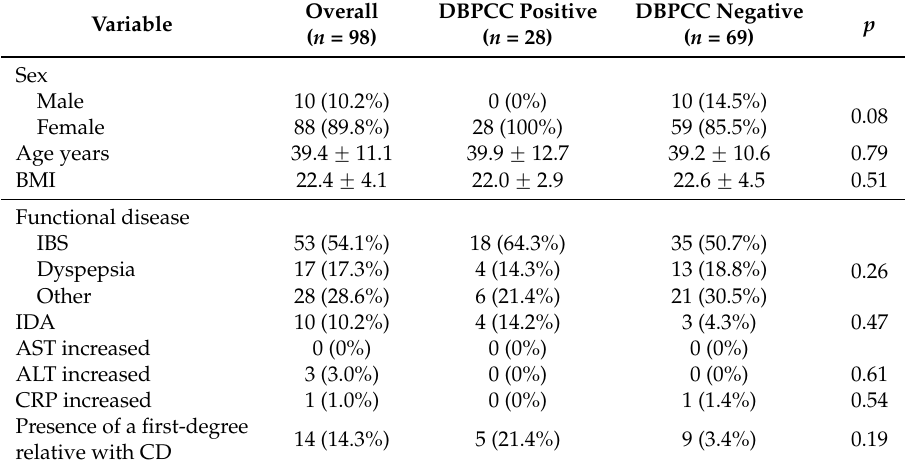
Table 3. Clinical and demographic characteristics of randomized patients during Phase 2 of the GLUTOX trial. The characteristics of the entire group of patients and those positive/negative to the gluten challenge are reported.